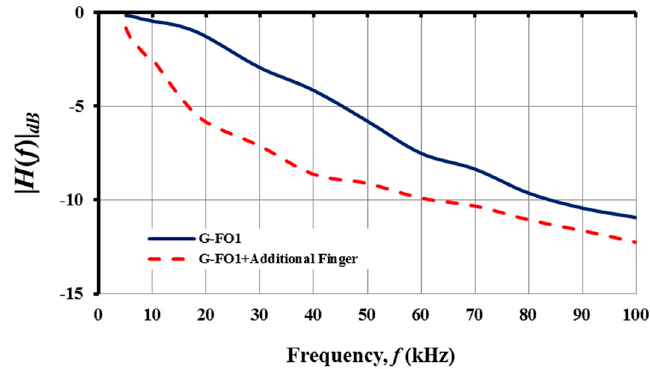
Figure 10. Change in the frequency response of the G-FO1 filter when capacitance is increased by introducing a foreign object to the IDC. Note that f c of G-FO1 is shifted from 30.5 kHz to 5 kHz when a finger is placed on the IDC component.